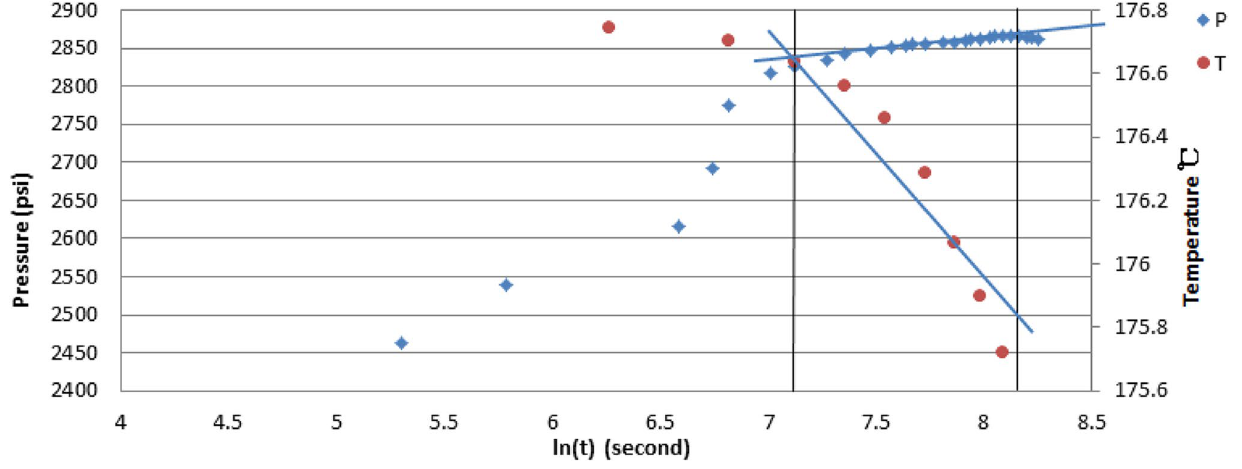
Fig. 12 TTA of transient I: ε ′ = dT/dP = 0.8/30 = 0.0267 C/psi